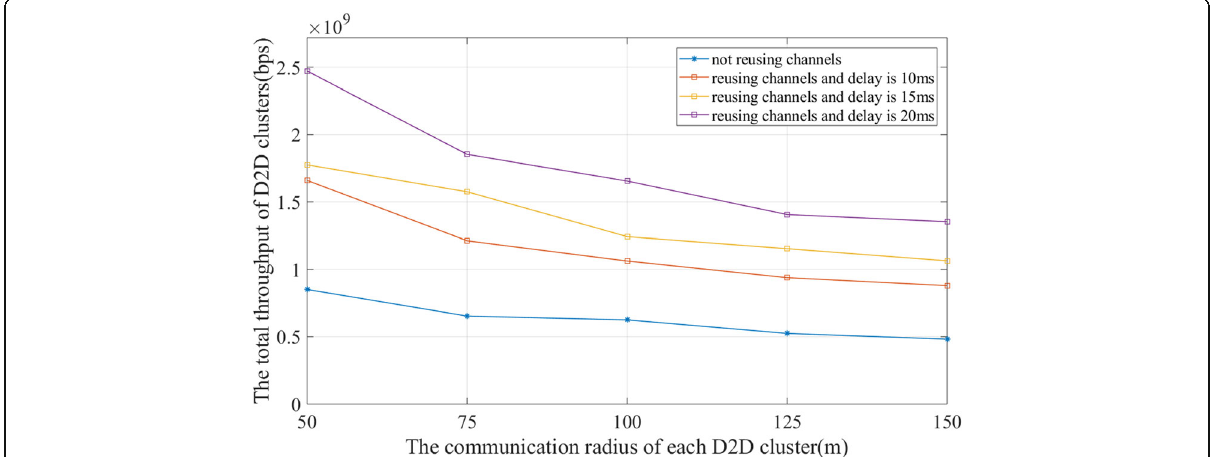
Fig. 6 The influence of the radius size of D2D clusters on the total throughput of D2D